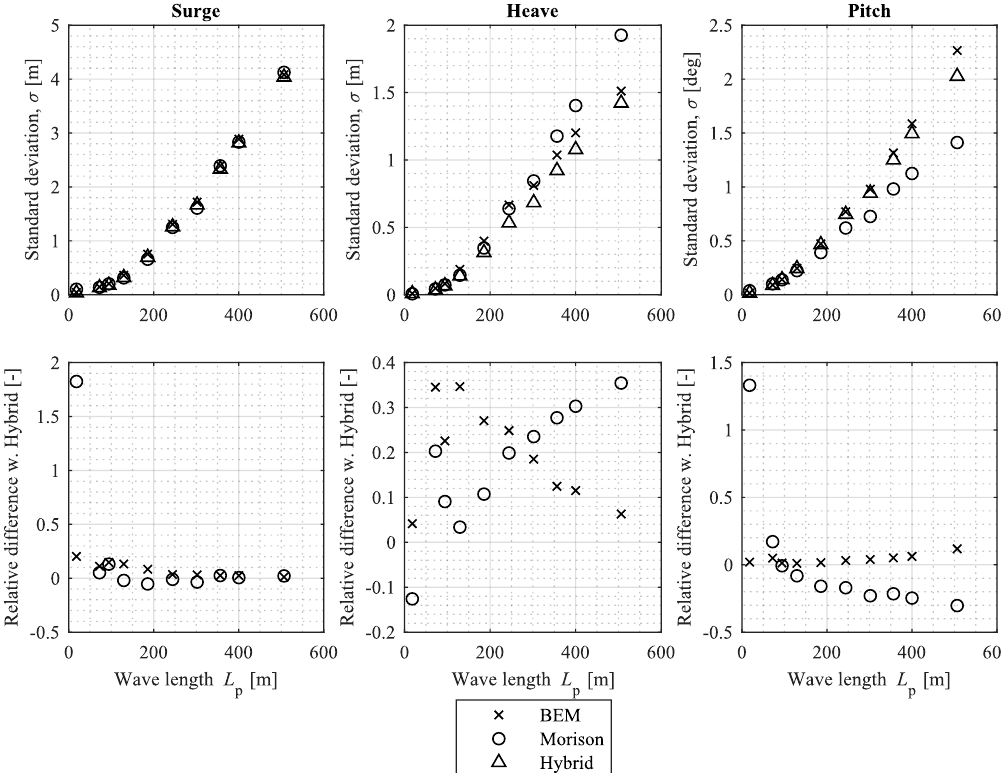
Figure 9. Top: Standard deviation, σ , of the surge ( left ), heave ( middle ) and pitch ( right ) DoF with updated drag coefficients. The bottom figures illustrates the relative difference with the hybrid model.